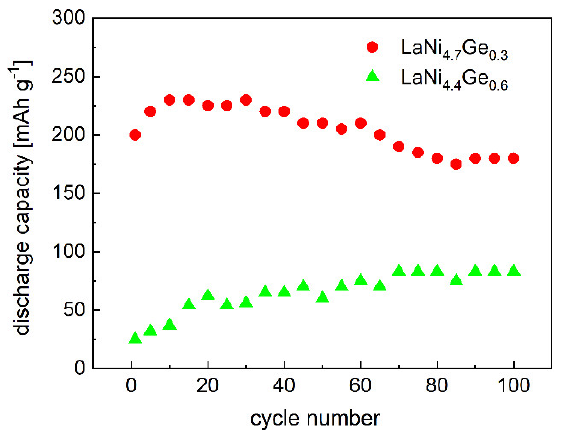
Figure 9. Cyclic stability curves of LaNi 5-x Ge x composite electrodes (charge/discharge current density: 500 mA g –1 ).